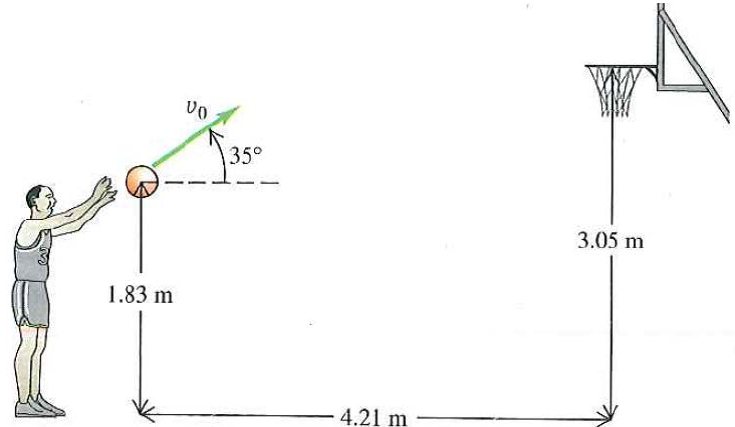
Fig. 1 Schematic diagram of basketball shooting